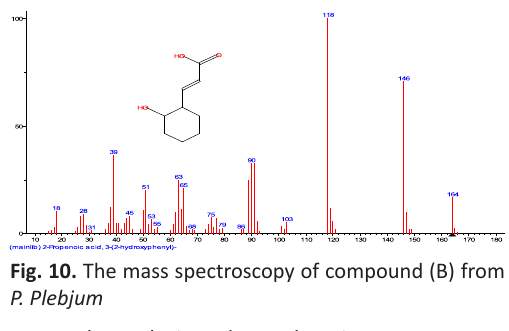
Fig. 10. The mass spectroscopy of compound (B) from P. Plebjum